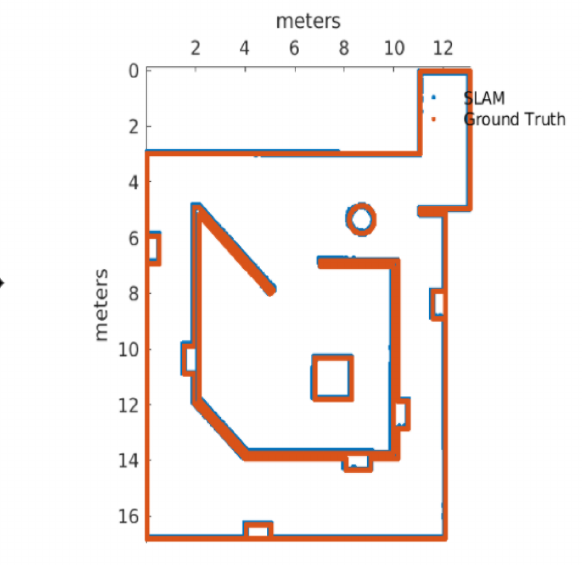
Figure 9. Map before and after the calibration of KARTO-SLAM. Table 10. Default, tuning and final values for